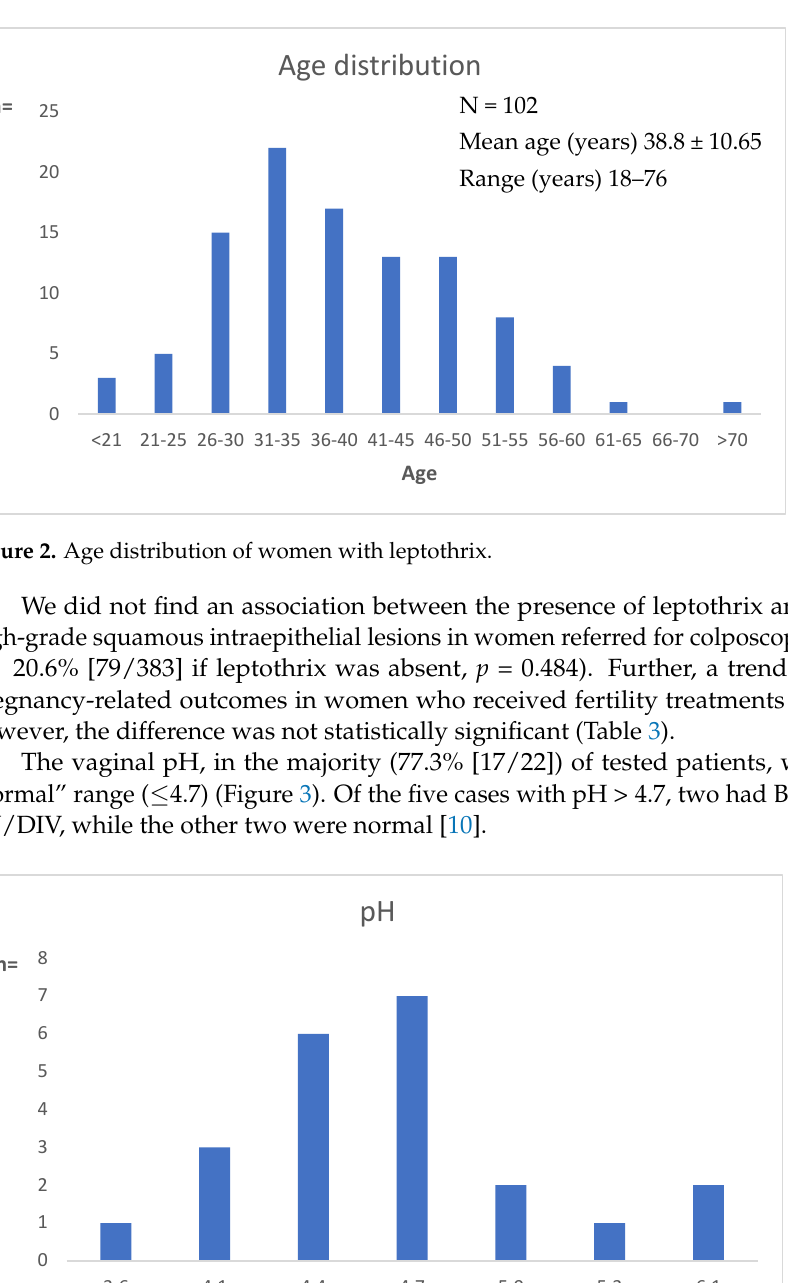
Figure 3. Vaginal pH distribution in women with leptothrix.